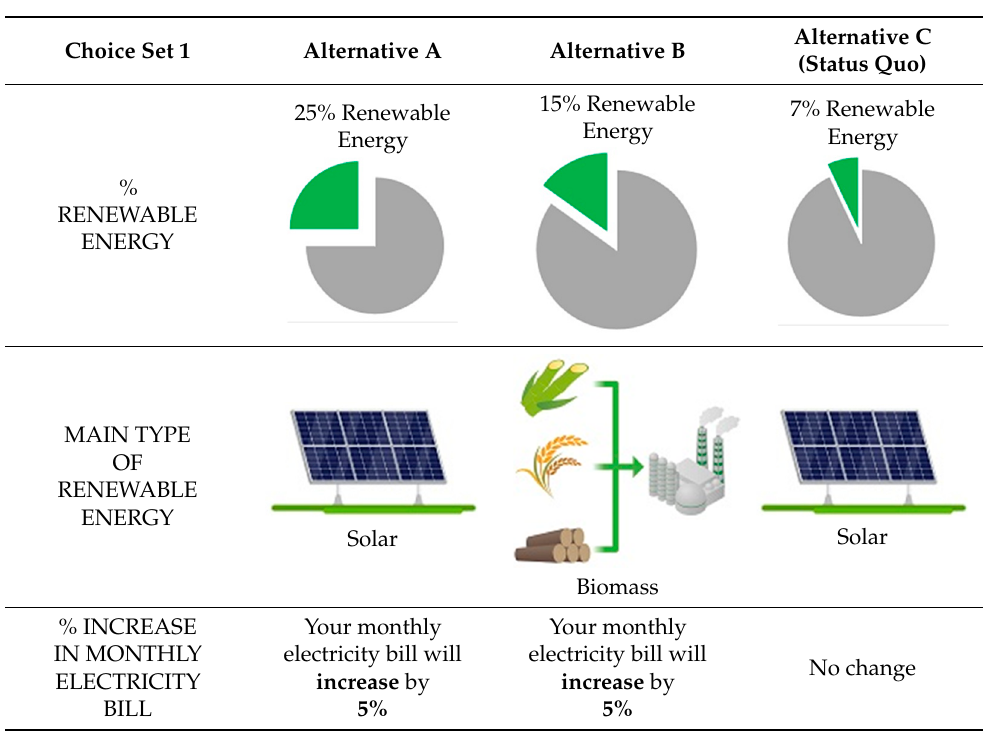
Table 2. Attributes and their levels for the survey.